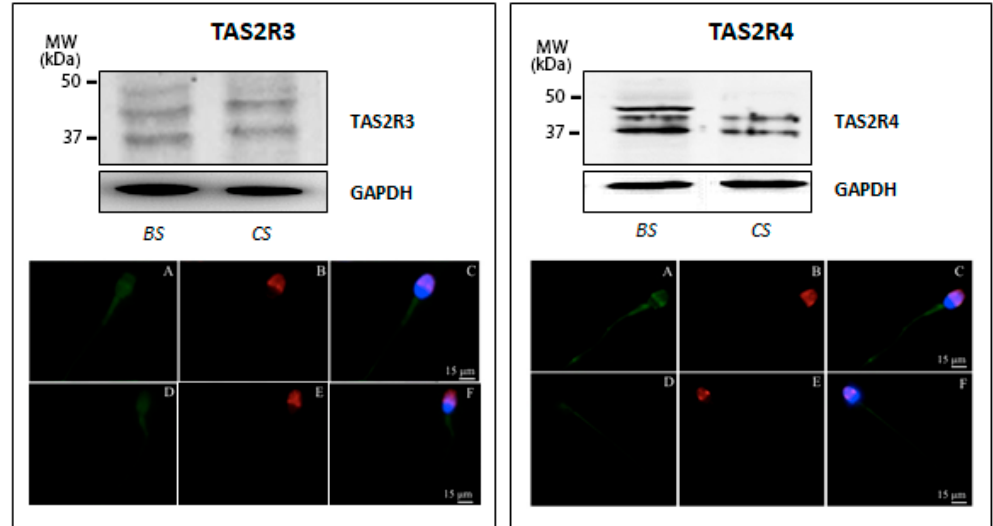
Figure 2. Expression of TAS2R3 (left panel) and TAS2R4 (right panel) in human ejaculated sperm. ( Top ) Western blot of TAS2R3 and TAS2R4 in ejaculated sperm before (BS) and after in vitro capacitation (CS). Equal protein loading of the two sperm preparations was verified using the housekeeping GAPDH. ( Bottom ) Representative micrographs (from three independent experiments) of immunofluorescence staining of TAS2Rs (green), the acrosomal lectin marker PSA (red) and the fluorescent DNA binding dye DAPI (6-diamino-2phenylindole, blue) in ejaculated sperm before ( A – C ) and after in vitro capacitation ( D – F ). Micrographs in C and F are composed by an overlay of the three fluorescent channels (TAS2Rs green; PSA, red; DAPI, blue); Scale bar = 15 μ m.